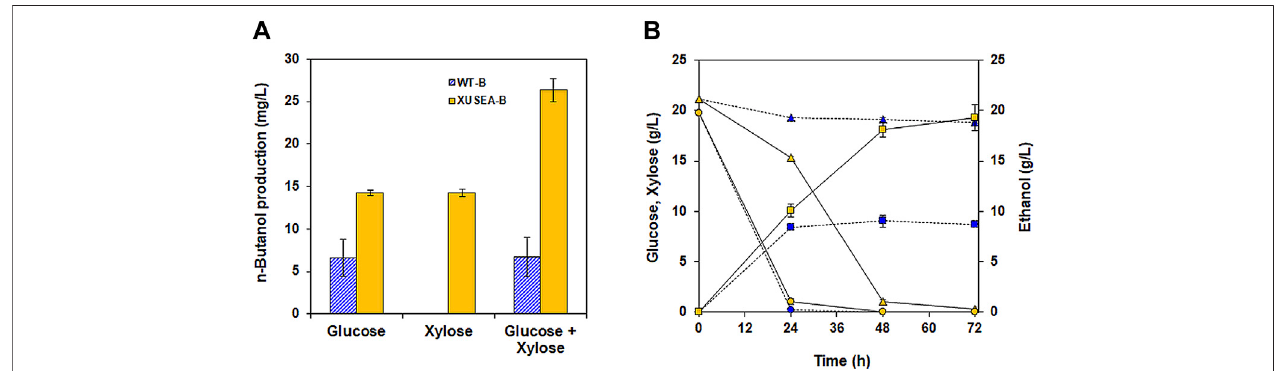
FIGURE2| Comparison ofn-butanol production between the WT-B (blue) and XUSEA-B (yellow) strainsduring glucoseand/or xylosefermentation.Fermentation was conducted with an initial OD of 0.2. (A) n-butanol titer after 72 h of fermentation. (B) glucose (circles)/xylose (triangles) consumption and ethanol production (squares) during co-fermentation. The error bars represent the standard deviations obtained using biological triplicates.